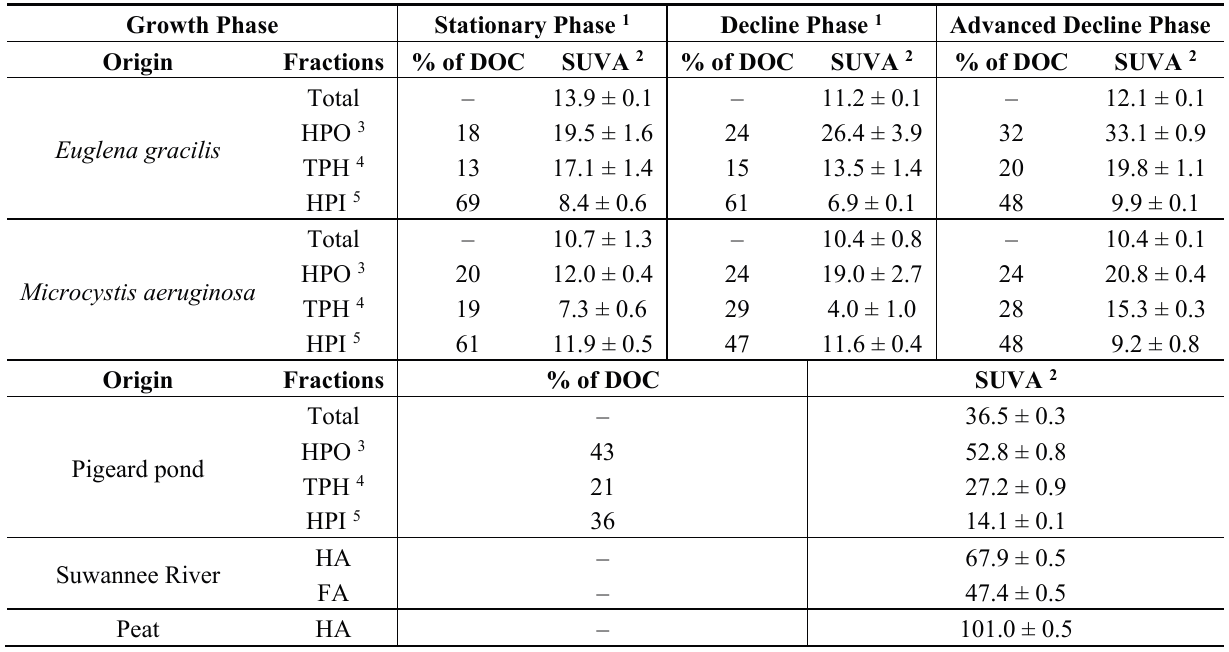
Table 1. Comparison of aromatic (SUVA) and hydrophobic properties (organic matter fractions content relative to dissolved organic carbon (DOC)) of algal organic matter (AOM) at various growth stages with natural organic matter